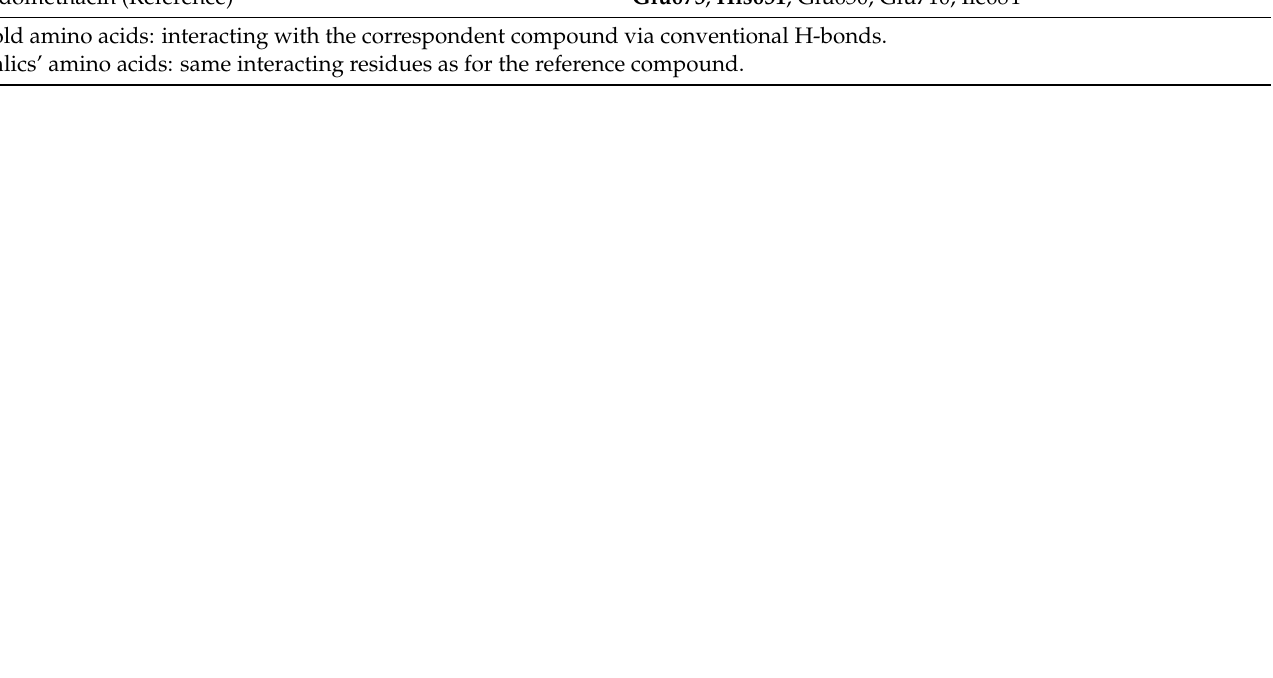
Bold amino acids: interacting with the correspondent compound via conventional H-bonds. Italics’ amino acids: same interacting residues as for the reference